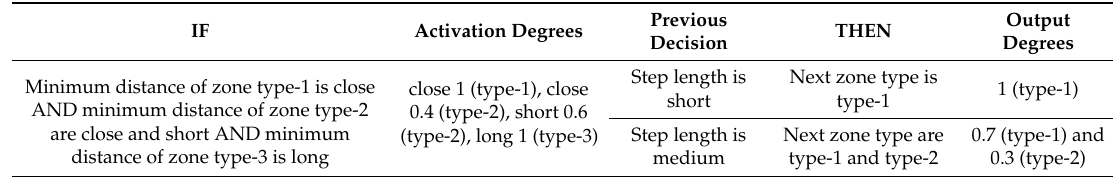
Table 3. The example of IF-THEN rules for the fuzzy system of moving direction.